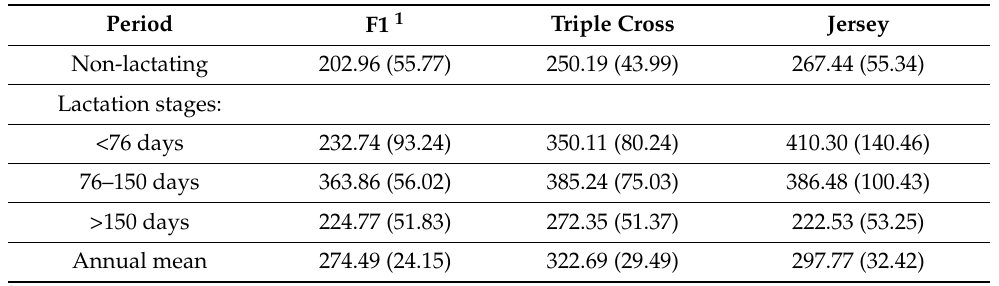
Table 3. Daily enteric CH 4 emissions in dry cows and at different stages of lactation by breed group (mean + sd).